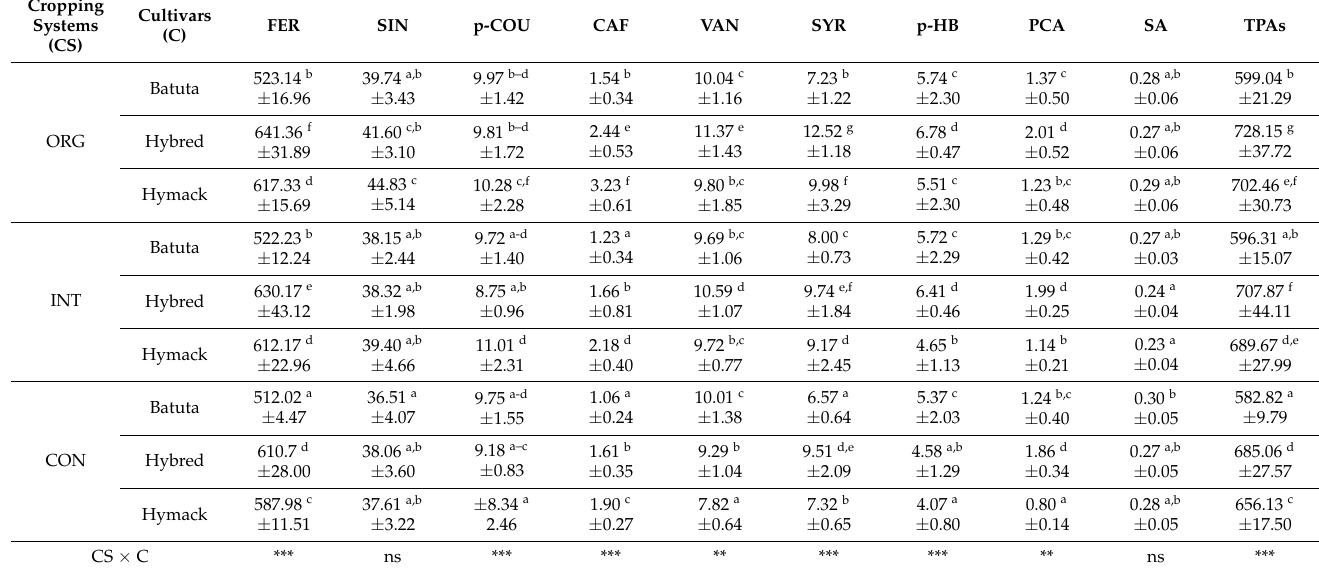
Table 4. Phenolic acid (PA) composition of wheat grain [ µ g g − 1 ], mean values for interaction cropping systems ×